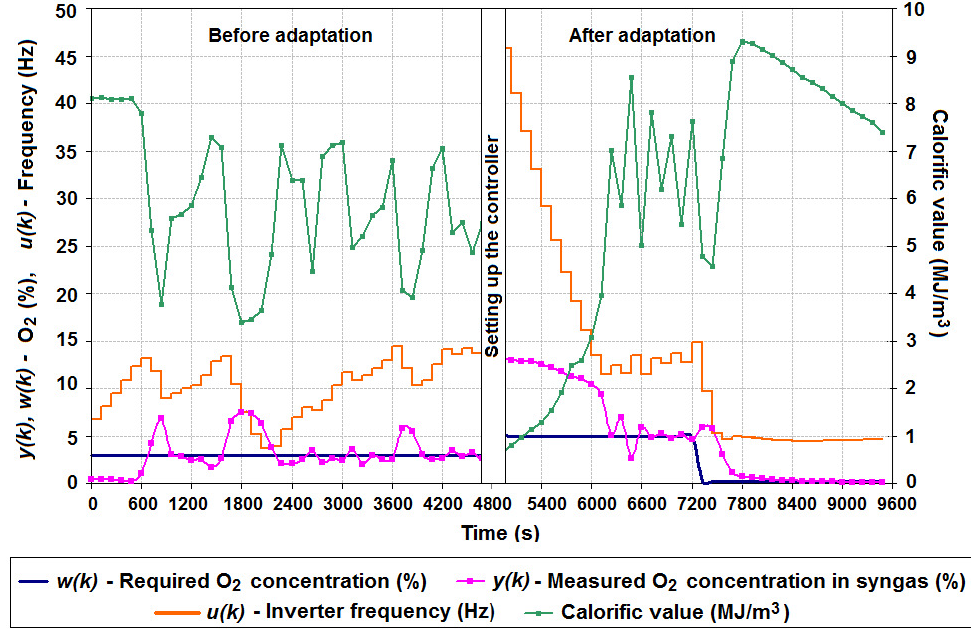
Figure 4. Oxygen concentration stabilization with controller adaptation [28].